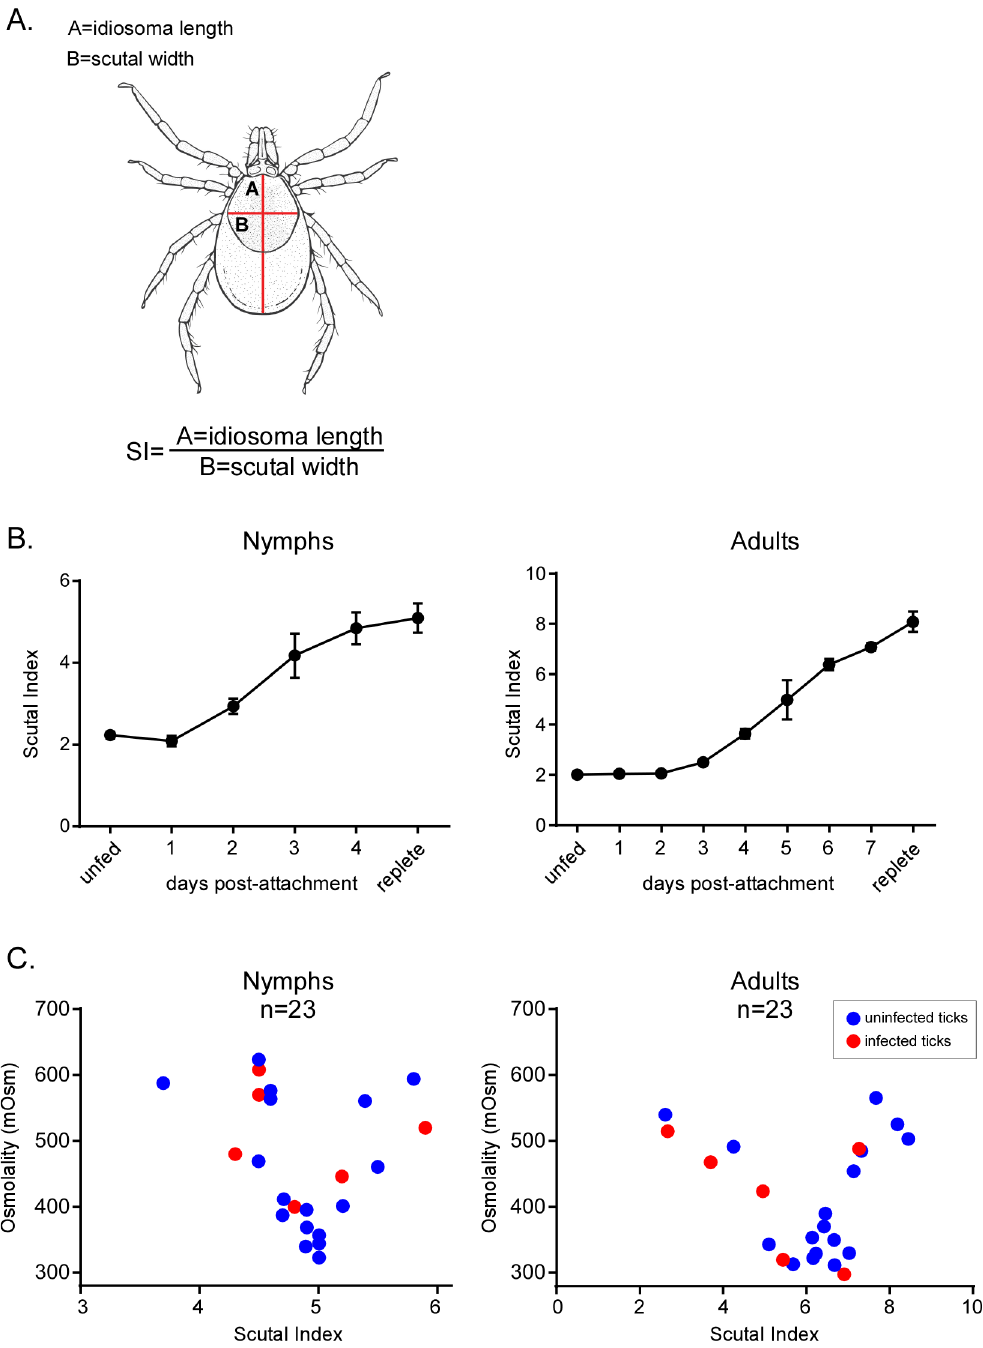
Fig 1. B . burgdorferi tolerates a narrow range of osmolarity (250 to 650 mOsm). (A) A drawing of an I . scapularis tick showing the measurements used to determine scutal index: A = idiosoma length, B = scutal width [35]. (B) Development of the scutal index during feeding of nymph and adult ticks. Each point represents the average of the measurements of 15 ticks. (C) Osmolarity of the blood meal isolated from the midgut of nymph or adult ticks during the feeding as a function of the scutal index. Each red circle denotes the osmolarity measured in the blood meal of an infected, feeding tick. Each blue circle denotes the osmolarity measured in the blood meal of an uninfected, feeding tick. Osmolarity was measured with Wescor vapor pressure osmometer as described in the Methods